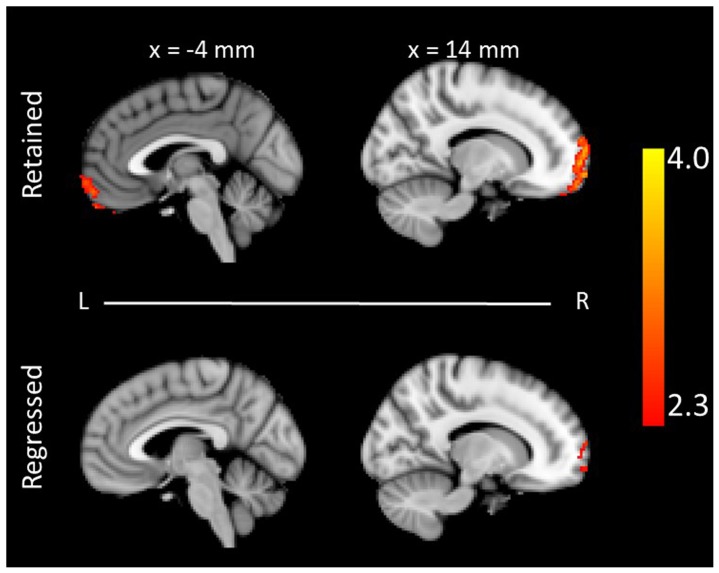
The neural correlates of impulsivity in the ADHD children.The ALFF value of the bilateral orbital frontal cortex and prefrontal cortex was positively correlated with the behavioral measure of impulsivity when the variable of head motion was either retained (top, Z > 2.3, p < 0.05, FWE corrected) or regressed out (bottom, Z > 2.3, uncorrected). The coordinate is in the MNI stereotactic space. ALFF: the amplitude of low-frequency fluctuation.